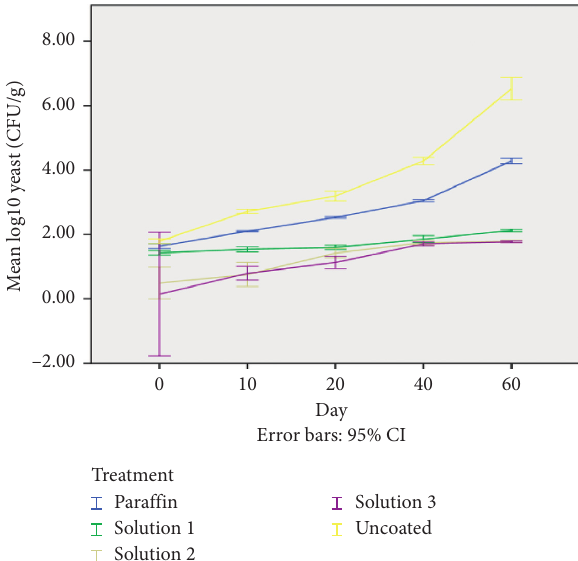
Figure 15: Yeast count (means ± SD) of cheese coated with an- timicrobial edible coatings compared with cheese coated with commercial coating and uncoated cheese throughout 60d of storage at 10 ° C and 85% relative